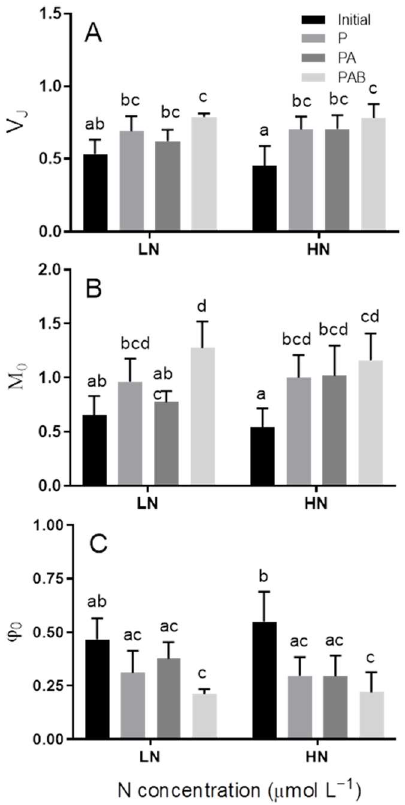
Figure 5. Chlorophyll a fluorescence transients (OJIP) of Sargassum horneri under LN ( A ) and HN ( B ) under P, PA, and PAB treatments. Significant differences among all treatments are indicated by different lowercase letters ( p < 0.05).